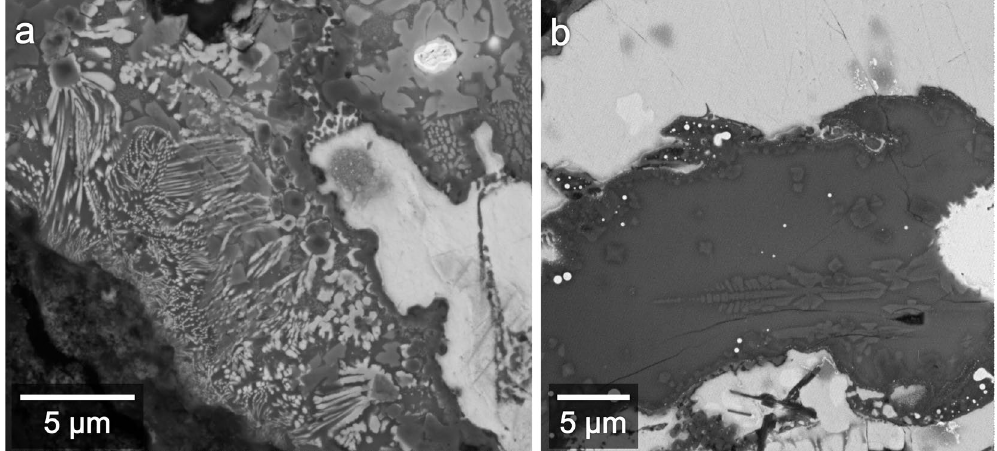
Figure 7. BSE images of skeletal, quench textures in the silicate glass. Individual phases are too small to analyze for precise compositions. ( a ) Close up of Location f.7a (Fig. 2b) showing granophyric textures. ( b ) Close up of Location 14 (Fig. 2b) showing feathery